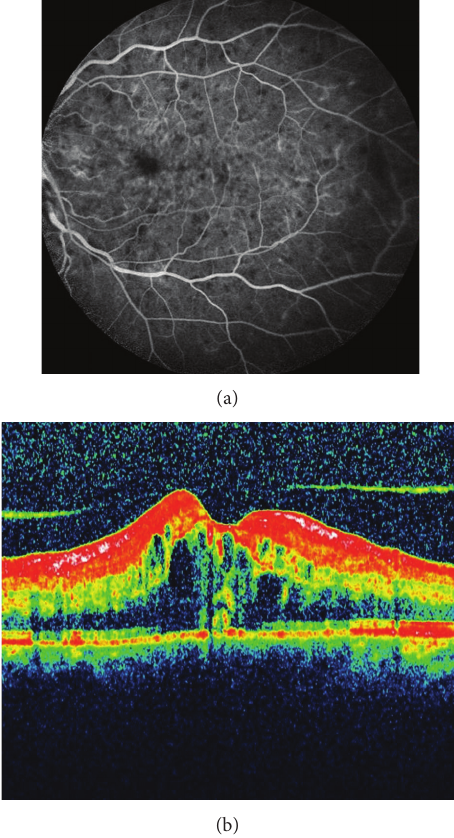
Figure 1: (a) Angiographic picture of the left eye depicting the cen- tral retinal vein occlusion and macular edema. (b) Optic coherence tomography showing the macular edema and attached vitreous in the left eye.